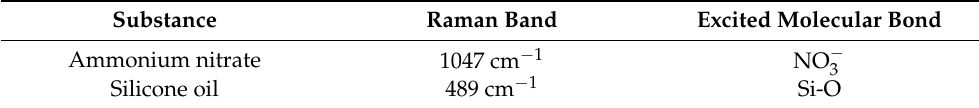
Table 1. Summary of detected Raman bands, including the respective excited molecular bond.